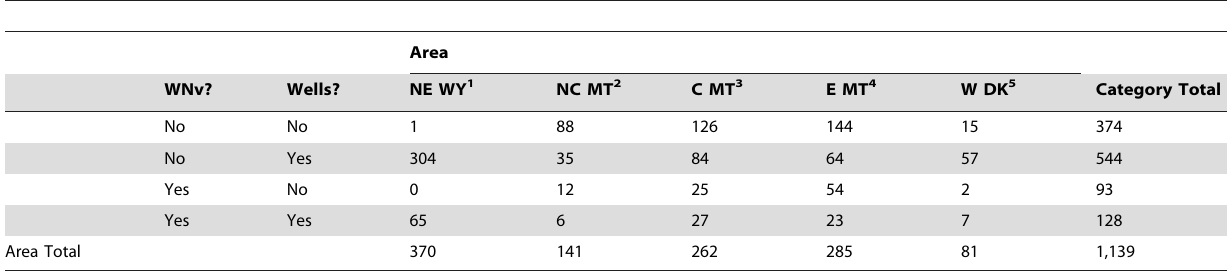
Table 2. Sample sizes of leks in study region categorized by sub-area, presence of wells within the 20 km best-fit radius and whether or not the lek was assigned positive WNv outbreak year status.